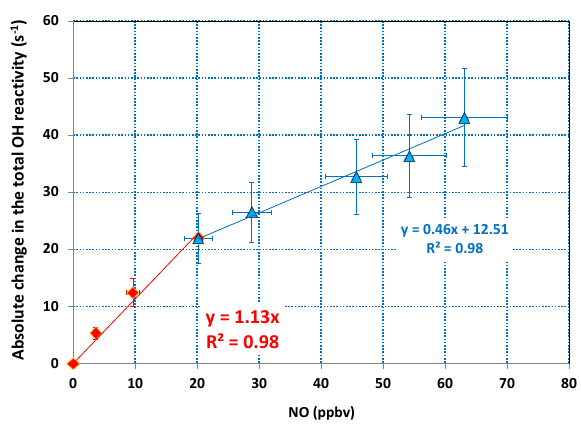
Fig. 5. NO test for OH reactivity of 50s − 1 : the red and the blue Figure 45. NO test for OH reactivity of 50s-1: the red and the blue curves represent the 2 2 curves represent the 2 different slopes obtained for values of NO different slopes obtained for values of NO smaller or bigger than 20ppbv 3 smaller or bigger than 4